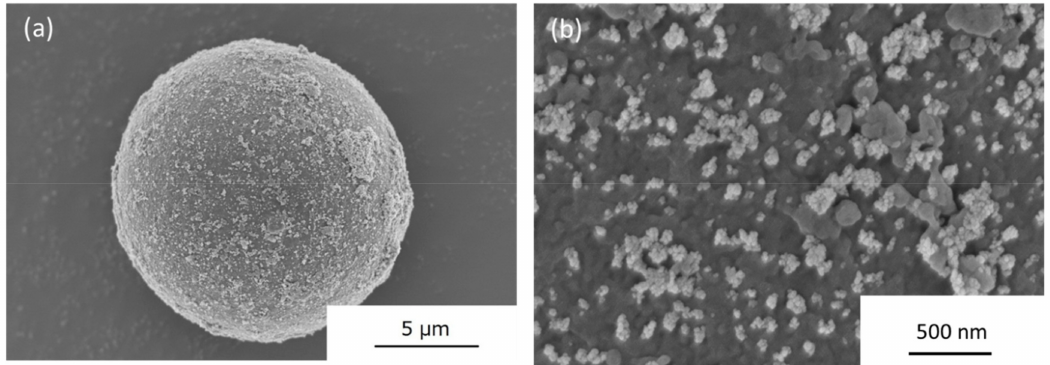
Figure 1. Scanning electron microscope (SEM) images of the PMMA-ITO composite obtained after electrostatic assembly adsorption of ITO nanoparticles that were surface-modified using PSS in ( a ) low magnification and ( b ) high magnification